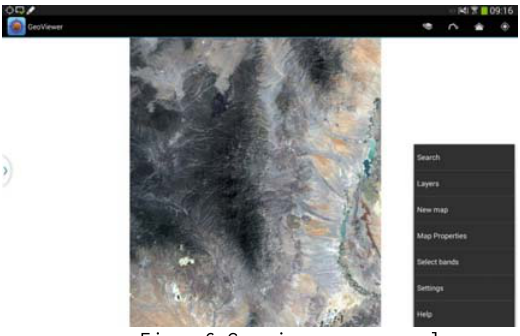
Figure 6. Geoviewer app